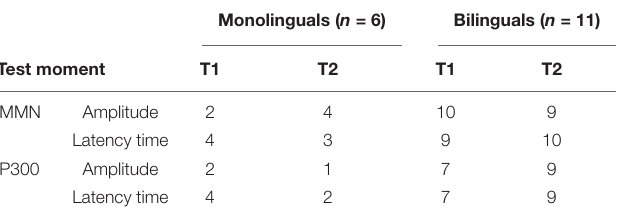
TABLE 1 | Number of mono- and bilinguals for which ERP parameters are situated within the normative values on T1 and T2. Monolinguals ( n = 6) Bilinguals ( n =